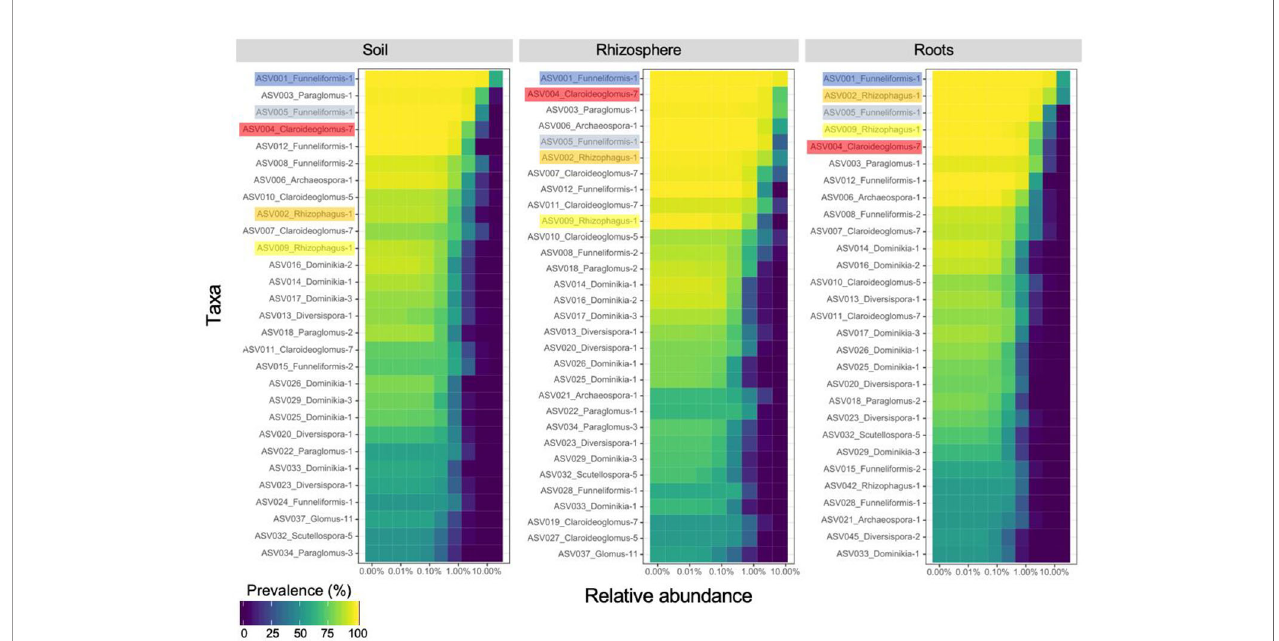
FIGURE 2 | Core community of arbuscular mycorrhizal fungi recovered in soil (29 ASVs), rhizosphere (30 ASVs) and root (29 ASVs) samples. The top fi ve amplicon sequence variants recovered in root samples are highlighted to emphasize their ranking in rhizosphere and soil samples. ASVs are ranked on the ordinate axis from the most (top) to the least (bottom) prevalent in each compartment while they are ordered by ascending relative abundance on the abscissa